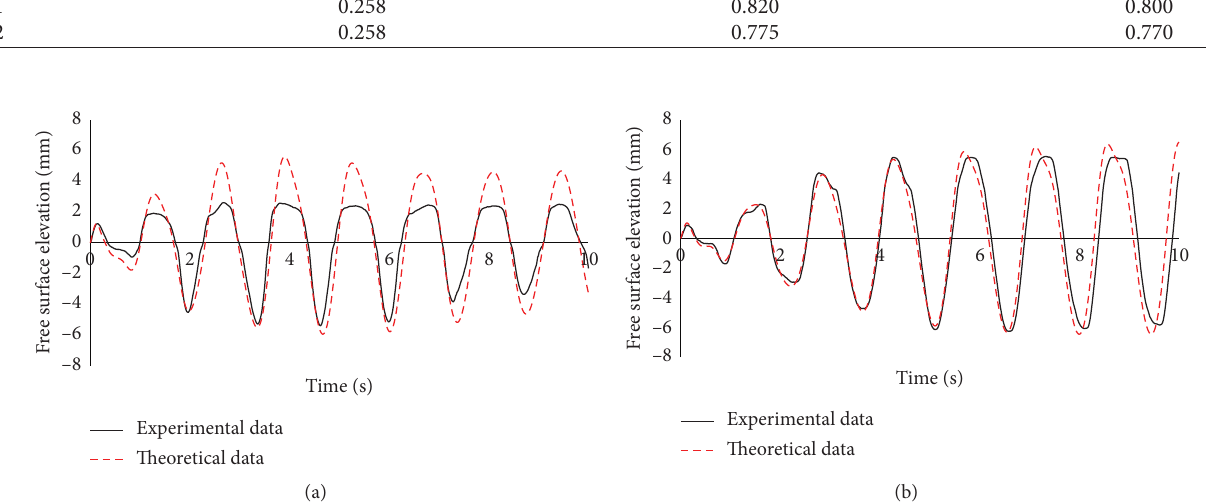
Figure 10: Comparisons of the free surface elevations of the experimental data and ADINA simulation under surge excitation: (a) Case 1: f � 0.72Hz, A � 0.002m; (b) Case 2: f � 0.69Hz, A � 0.002m.